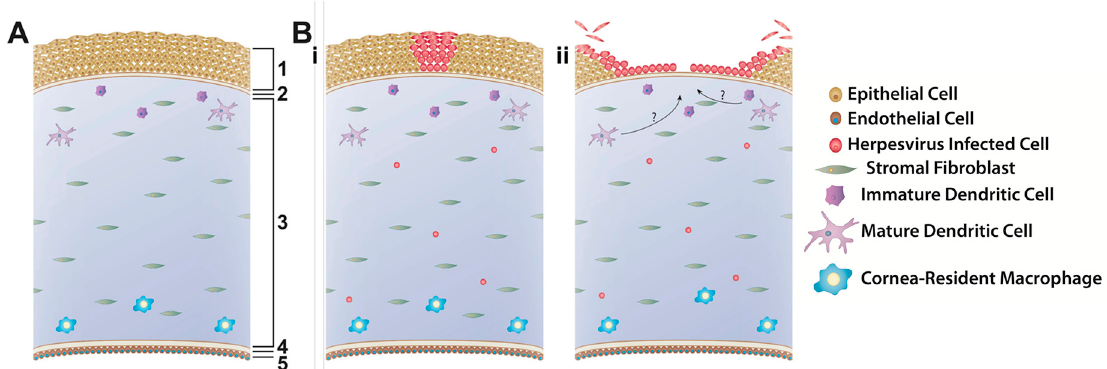
Figure 2. General progression of lytic herpesvirus infection in cornea explant models. ( A ) Structure of normal cornea with the five layers indicated: (1) epithelium, (2) Bowman’s layer (absent in felines and canines), (3) stroma, populated by stromal fibroblasts and various resident immune cells, (4) Descemet’s membrane and (5) endothelium; ( B ) following herpesvirus infection of the cornea explant, corneal epithelial cells become infected in a dose-dependent manner, resulting in the formation of plaques and dendrites. Unidentified stromal cells may also become infected (i). Following prolonged incubation, corneal epithelial cells are lysed and slough off into the culture media, leading to complete destruction of the epithelium (ii). The contribution of resident corneal immune cells in the host response to herpesvirus infection has not been formally investigated in explant cultures to date.